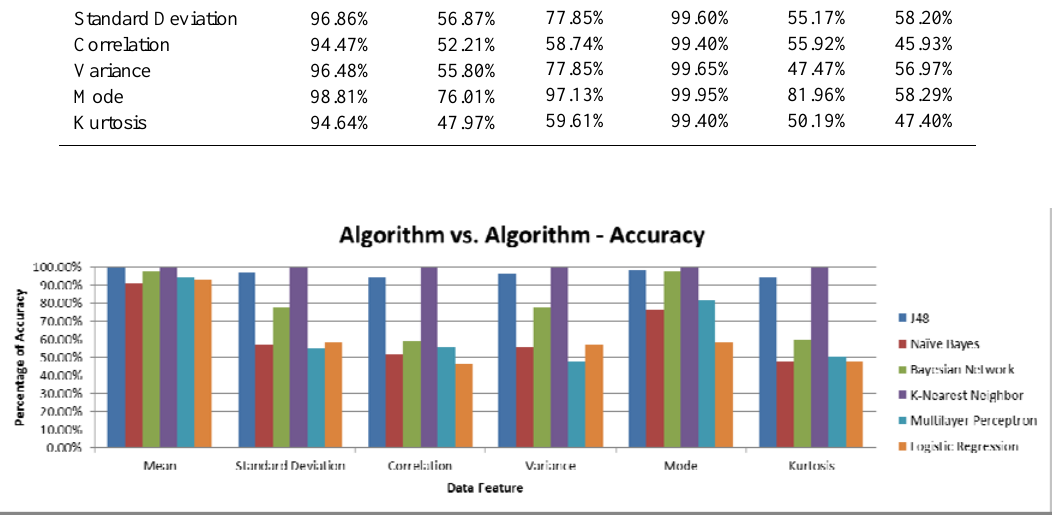
Fig. 2. Algorithm vs. algorithm comparison in terms of accuracy